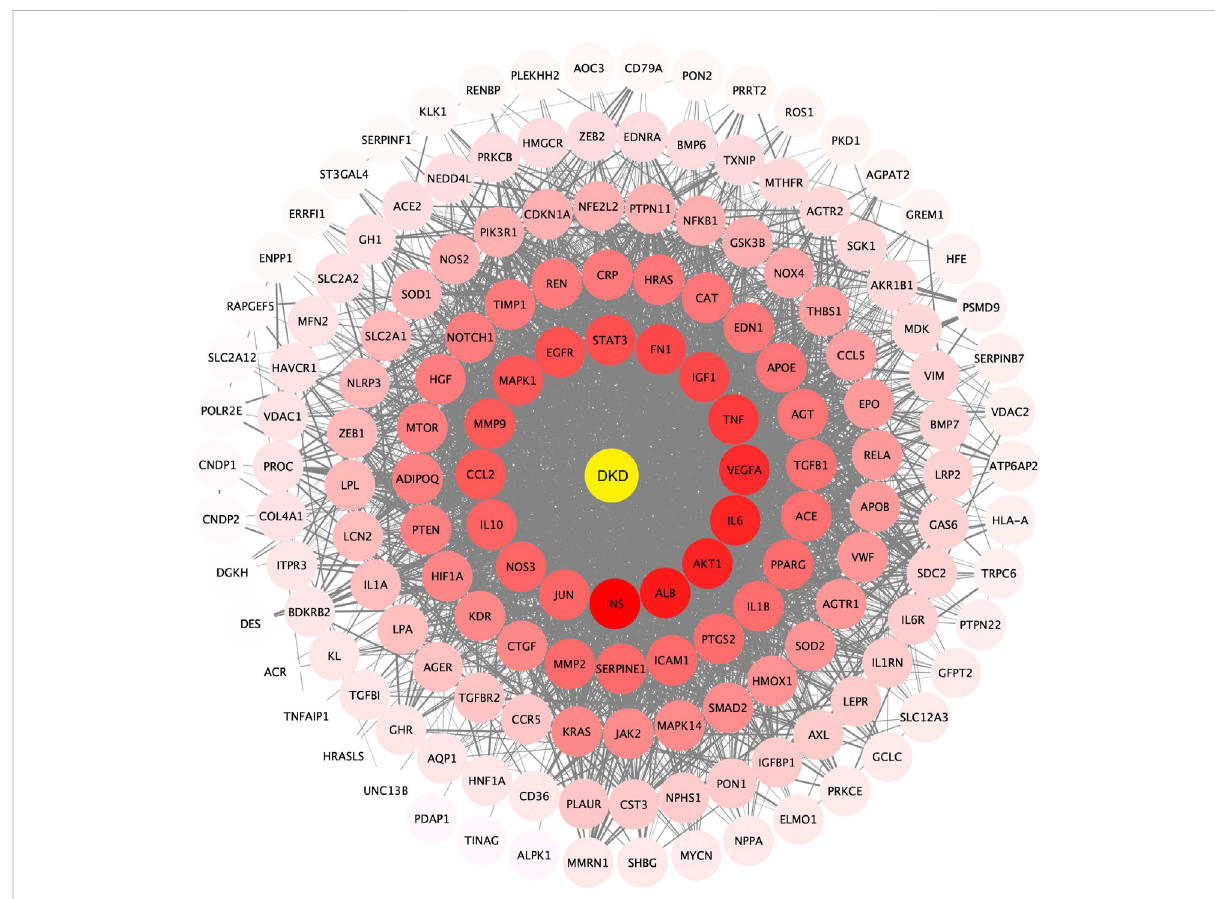
FIGURE 3 Protein-protein interactions network of DKD targets. Color and location of one protein represent the number of connections with other proteins. The redder the color and the more central the position, the more interaction with other proteins. FDR: false discovery rate. DKD: diabetic kidney